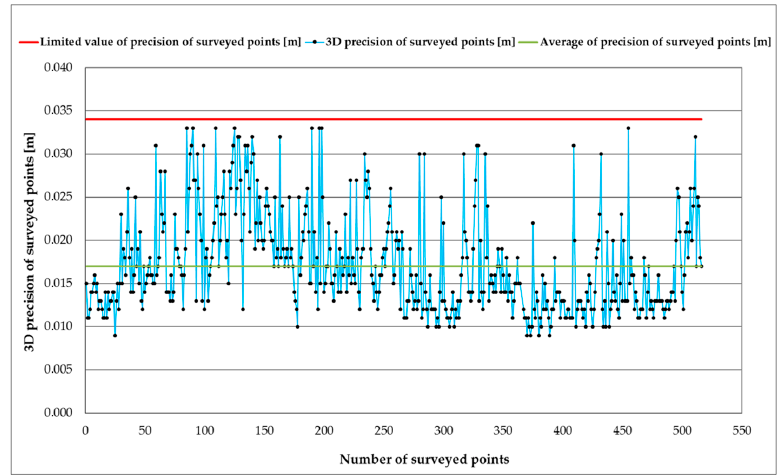
Figure 4. Presentation of the spatial accuracy of the point’s position.